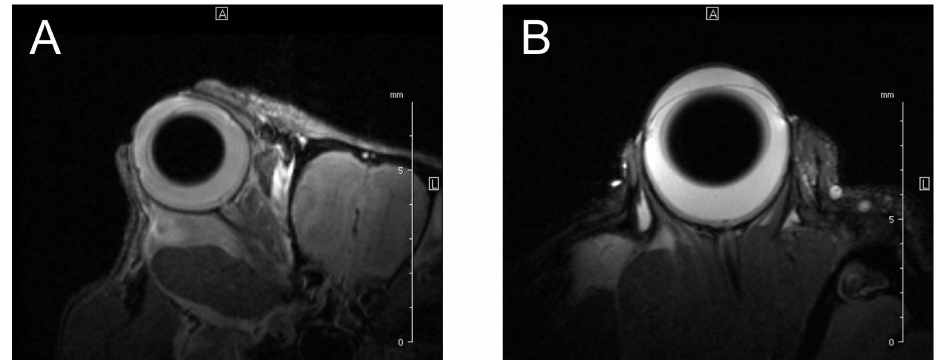
Figure 7. T2-weighted MR images of the eyes of experimental animals—( A ) mouse and ( B ) rat. High-resolution images enable detailed evaluation of the ocular